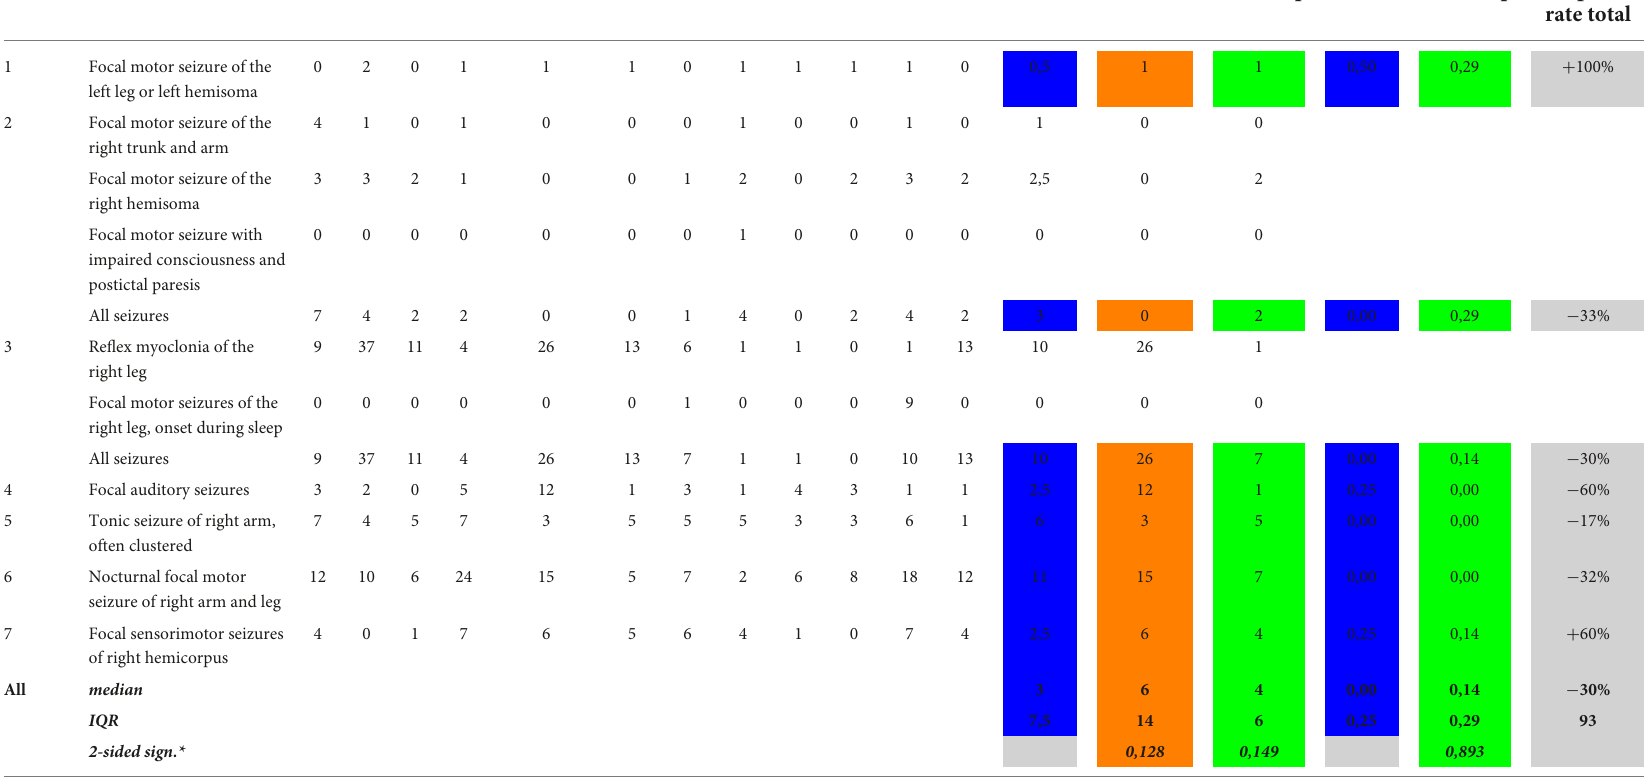
TABLE 3 Seizure frequency